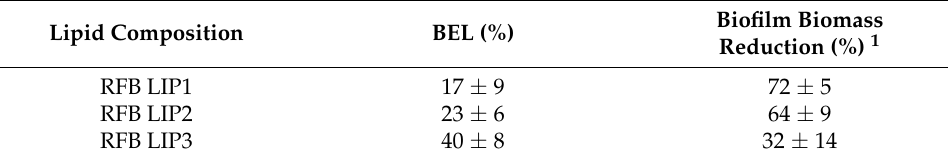
Table 4. RFB-loaded liposomes interaction with mature MSSA biofilm: biofilm transwell model. Lipid Composition BEL